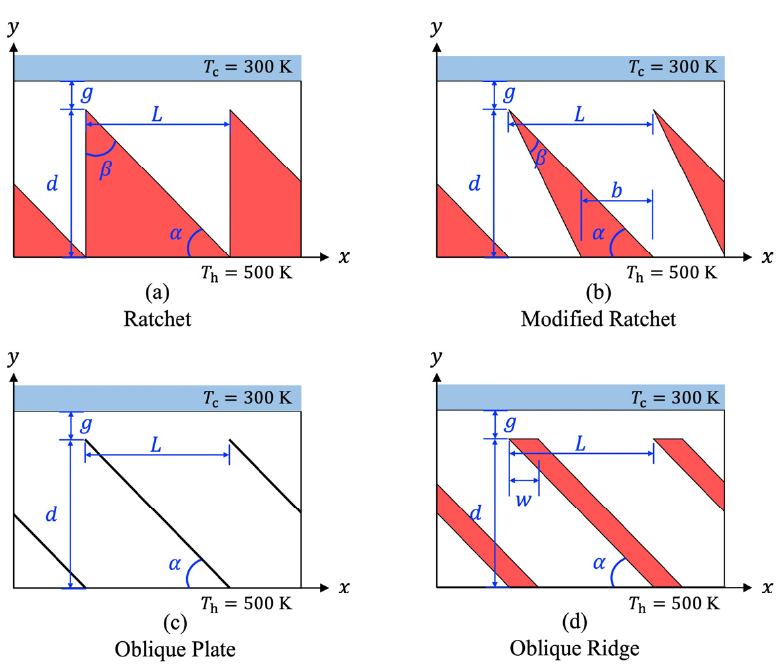
Figure 1. Schematics of the substrate with different surface microstructures.